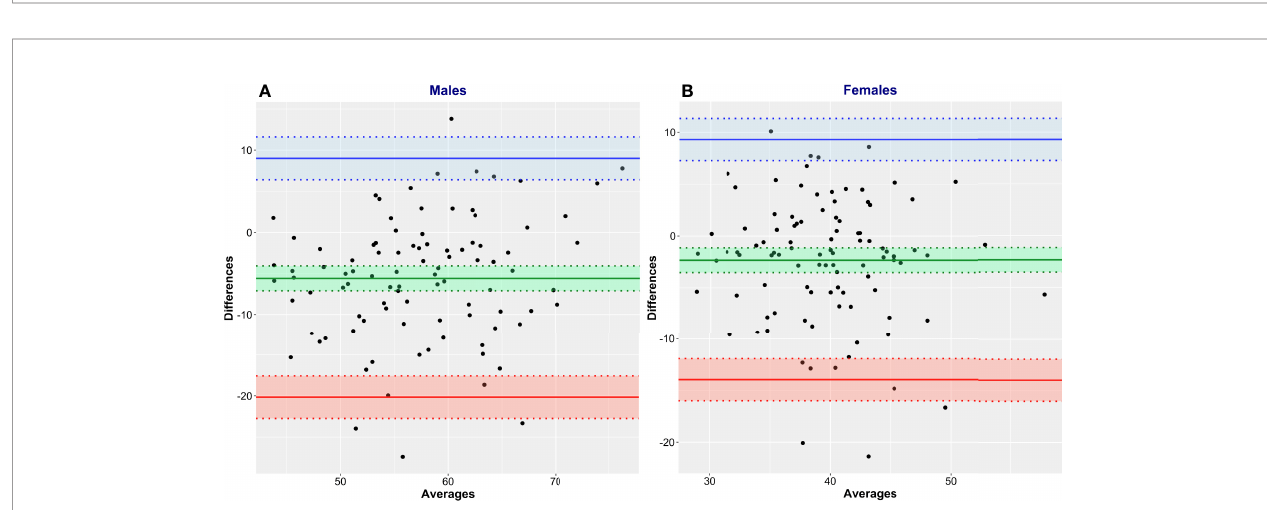
FIGURE 6 | Bland and Altman plots of CT-de fi ned lean body mass (LBM CT ) vs. that estimated by Janmahasatian ’ s equation (LBM Janma ). LBM CT is the reference method, and LBM Janma is the test method. Men (A) and women (B) .